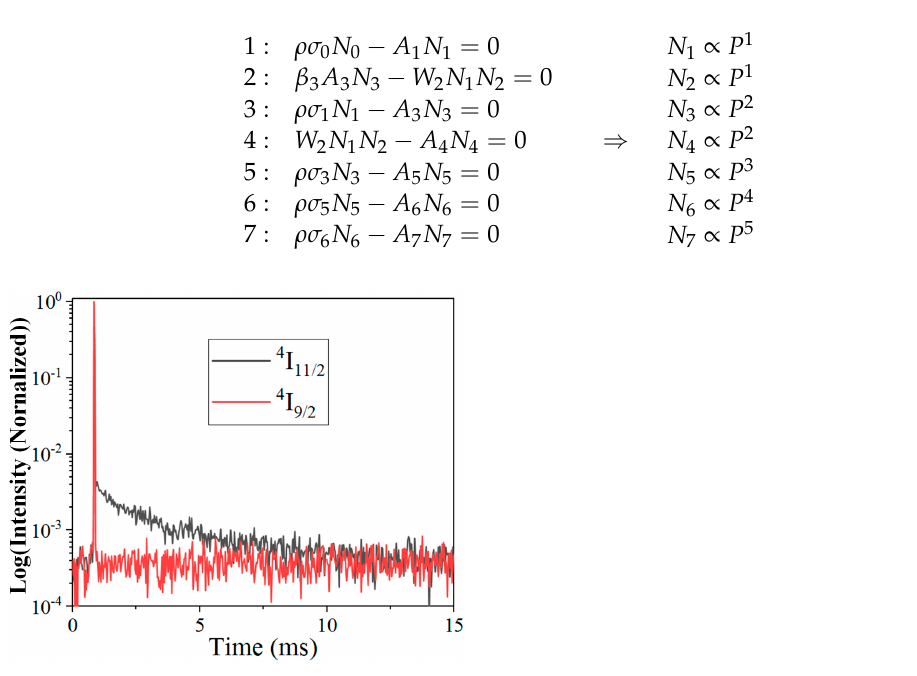
Figure 7. Time − resolved Er 3+ emissions at 800 nm ( 4 I 9/2 ) and 980 nm ( 4 I 11/2 ) via pulse 795 nm and pulse 975 nm excitation, respectively.